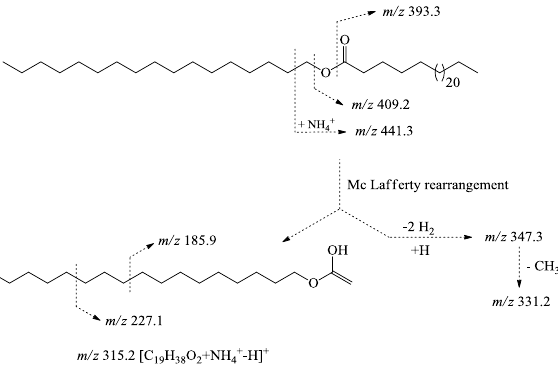
Figure 3. Important fragmentation of compound 4 Nonacosane ( 1 ), heptatriacontanol ( 2 ), Docosanol ( 3 ), D-mannitol ( 5 ), D-mannitol acetate